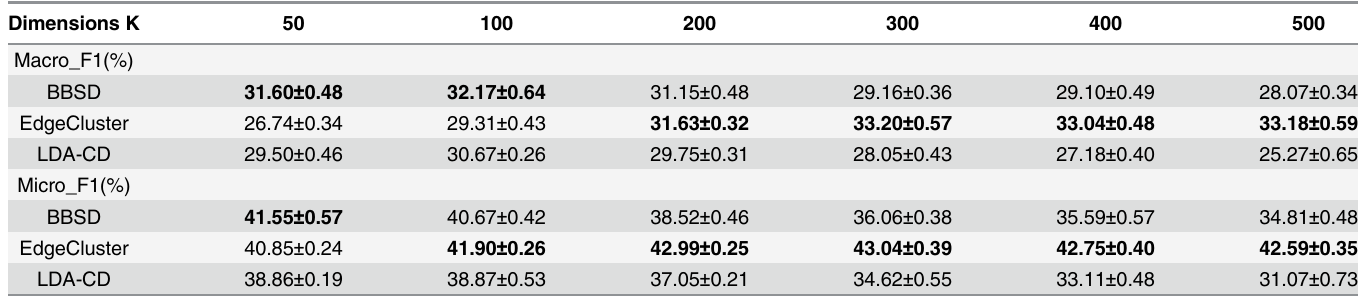
Table 9. Parameter sensitivity to social dimensions on YouTube (LP =